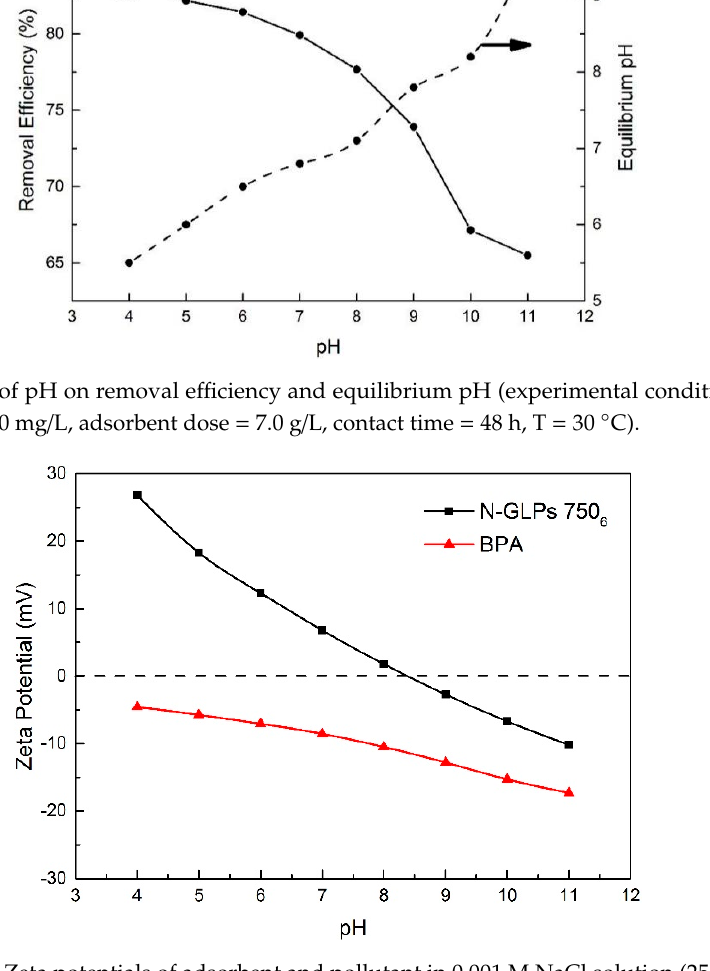
Figure 11. Zeta potentials of adsorbent and pollutant in 0.001 M NaCl solution (25 °C).